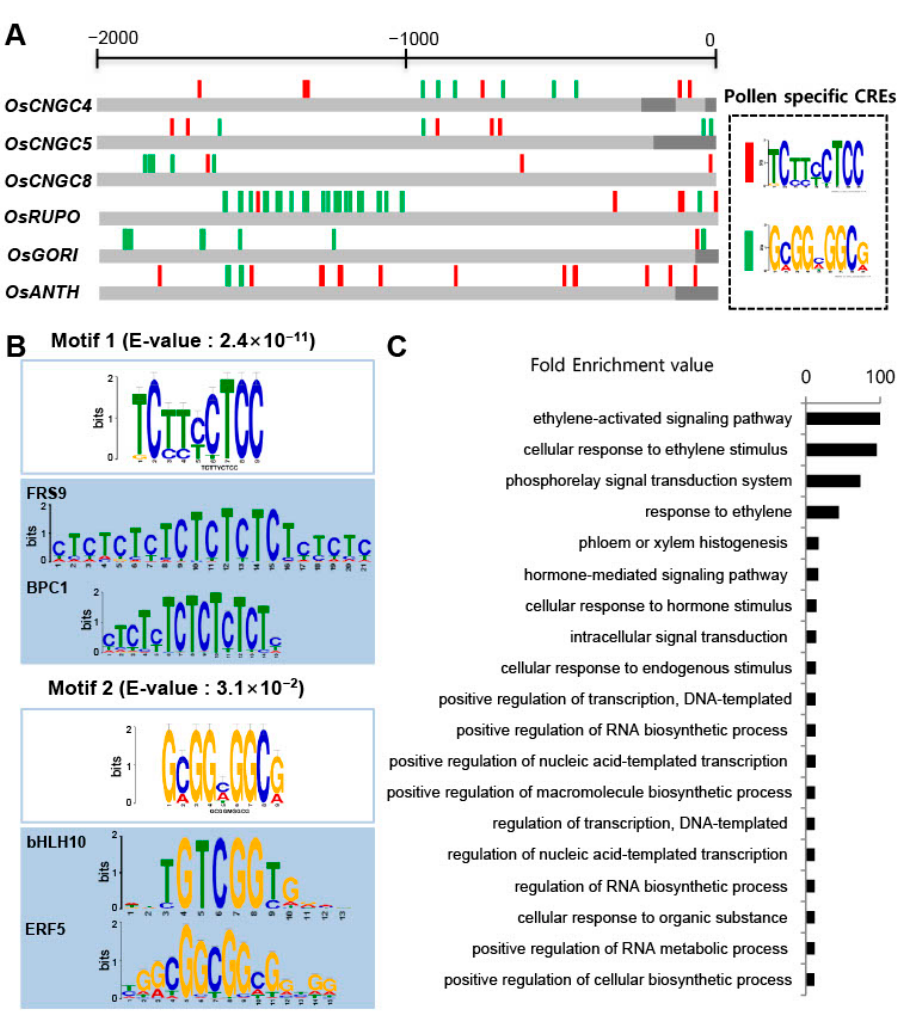
Figure 4. ( A ) Identification of putative cis-acting regulatory elements (CREs) found in pollen-preferential-expressed OsCNGC genes with OsRUPO, OsGORI, and OsANTH using the MEME suite. The number on the scale bars above the figure shows the upstream position of the promoter base pair when taken at +1 of ATG. Up to the upstream, 2000 base pairs were analyzed. Deep gray bars indicated the 5’-untranslated regions and brown bars indicate the promoter regions. ( B ) Sequence motifs for transcription factors with sequence similarity to pollen-preferential CREs. ( C ) A Gene